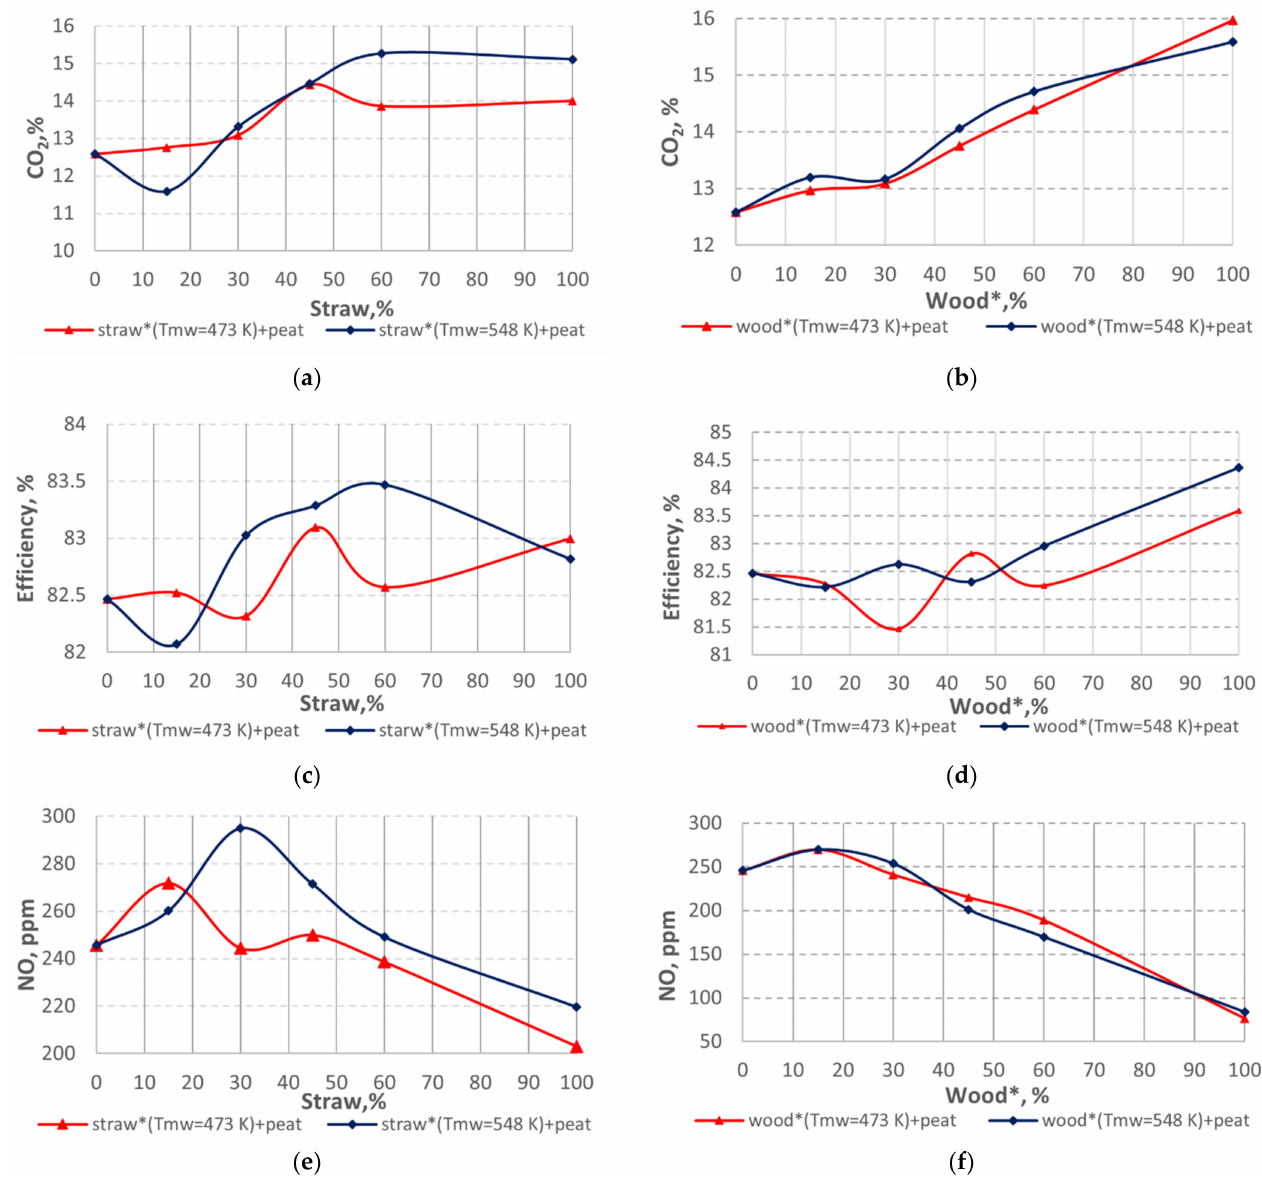
Figure 6. Effect of changes (variations) in pre-treatment temperature and composition of selectively pre-treated wheat straw* ( a , c , e ) and wood* ( b , d , f ) blends with raw peat pellets on the average values of the volume fraction of CO 2 emission in the products ( a , b ), combustion efficiency ( c , d ) and on the mass fraction of NO x emission in the products ( e , f